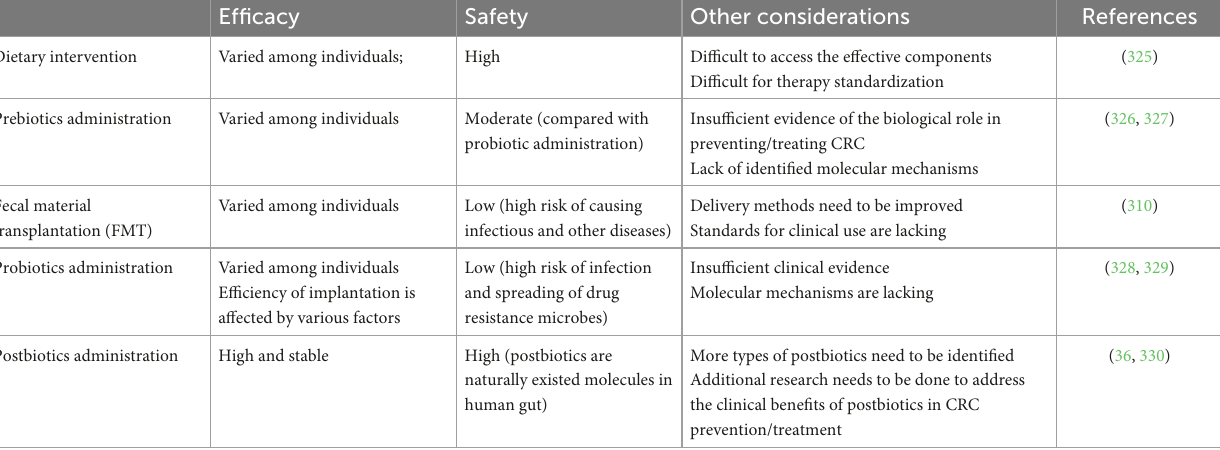
TABLE 3 Comparison of different strategies in treating colorectal cancer